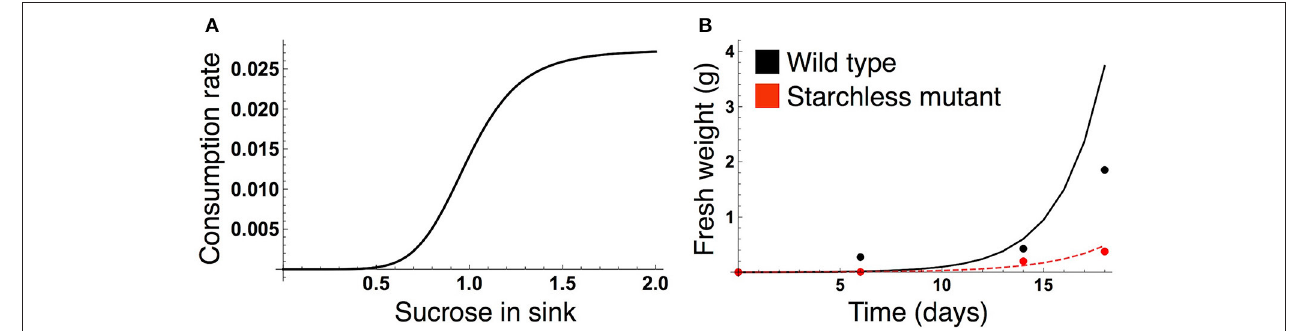
FIGURE 2 | (A) Sucrose consumption rate α for growth of the sink (SAM or RAM). The unit for sucrose is µ molC 6 g − 1 FW. (B) Time evolution of growth of the wild type (black) and the starchless pgm mutant (red) grown in a 12-h photoperiod. In (B) , lines represent the sum of the simulated growth of the two sinks and circles represent the published growth data ( Caspar et al.,